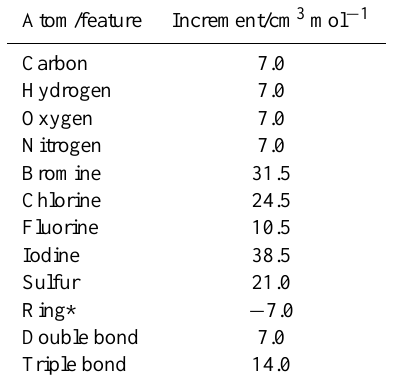
Table 3. Schroeder additive method for calculating V b . For all atoms/structural items a molecule contains, the sum of the incre- ments will give the molar volume. e.g. CH 2 =CH 2 contains 2 car- bon atoms, 4 hydrogen atoms and 1 double bond so the Schroeder V b is 2 × 7 + 4 × 7 + 7 = 49cm 3 mol − 1 ∗ applies to all kinds of cyclic features and is applied only once to ring-containing compounds ir- respective of the number of rings present.